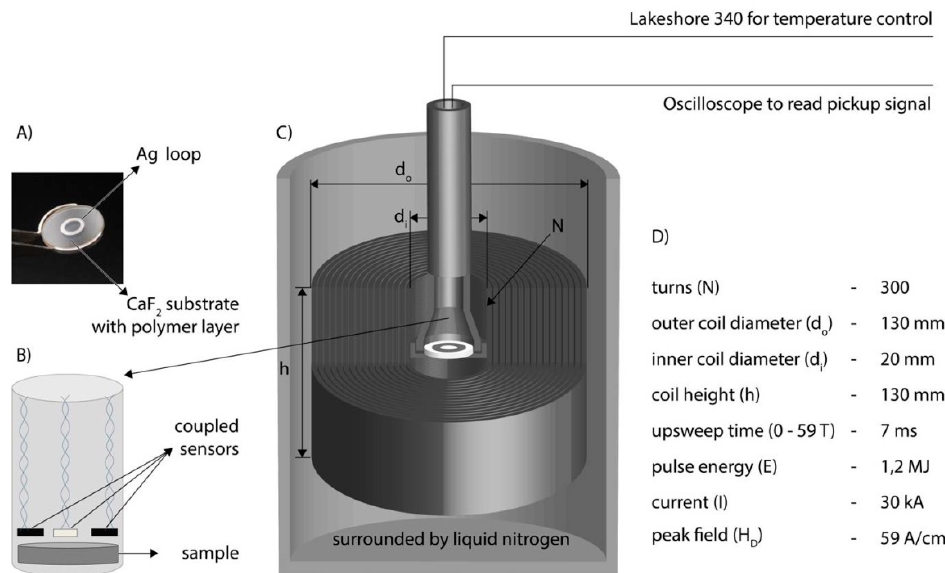
Figure 4. Schematic drawing of experimental set-up and parameters for magnetic-field pulse. ( A ) Photograph of a sample with silver ring on a spectroscopic substrate. ( B ) Schematic drawing of the thermo- and magneto-sensors near the sample surface. ( C ) Position of the sample and the pulse setup. ( D ) Specifications and coil parameters.